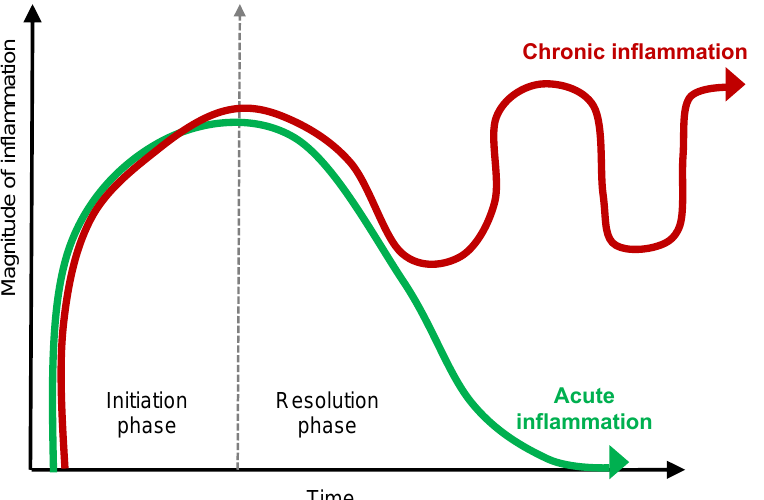
Figure 1. The Dynamics of Chronic Inflammation. The acute inflammatory response is transient and programmed to resolve, which is what occurs in a state of health. Failure of resolution results in prolonged or chronic inflammation with tissue remodeling, fibrosis, and disease. Persistence or chronicity occurs when the inflammatory response is unequal to the task of eliminating antigenic stimuli, such as foreign bodies or microorganisms, or other inflammatory triggers including urate crystals, cholesterol crystals, silica, and excess reactive oxygen species (ROS) production [6]. The chronicity of inflammation is associated with a host of conditions, such as inflammatory bowel disease, cancer, type 2 diabetes, heart disease, and autoimmune disorders such as rheumatoid arthritis, multiple sclerosis (MS), and systemic lupus erythematosus (SLE). At the other end of the spectrum is hyperinflammation, which occurs with the exaggerated expression of pro-inflammatory mediators as in sepsis, septic shock, and severe COVID-19 [7].